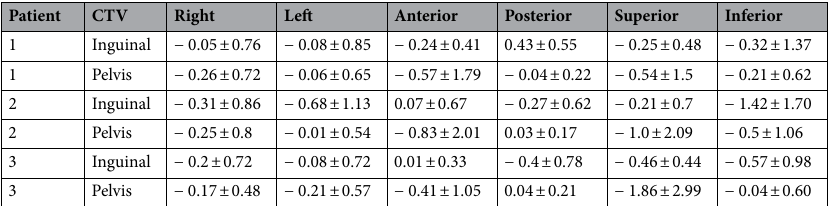
Table 3. Difference of borders along the 6 direction between each clinical target volume (CTV) and STAPLE generated CTV with confidence level of 80% (CTV-80). Number represented mean ± standard deviation in centimeter. Positive values represents that border of each CTV is larger than CTV-80 in each direction.